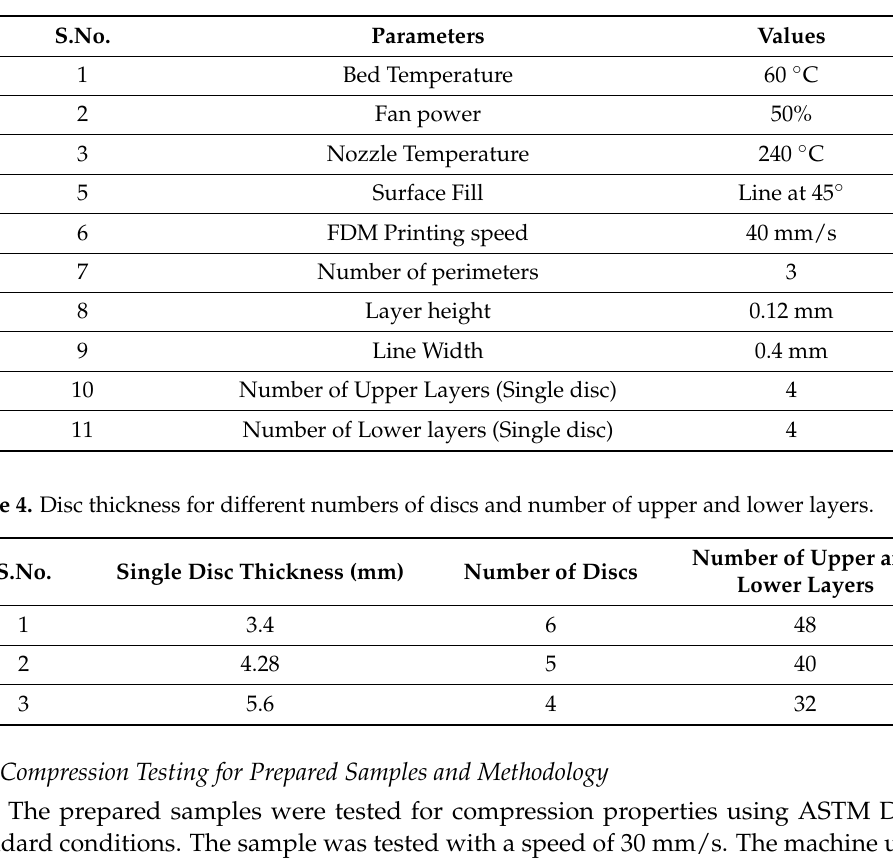
Table 3. Fixed condition used for FDM printing.